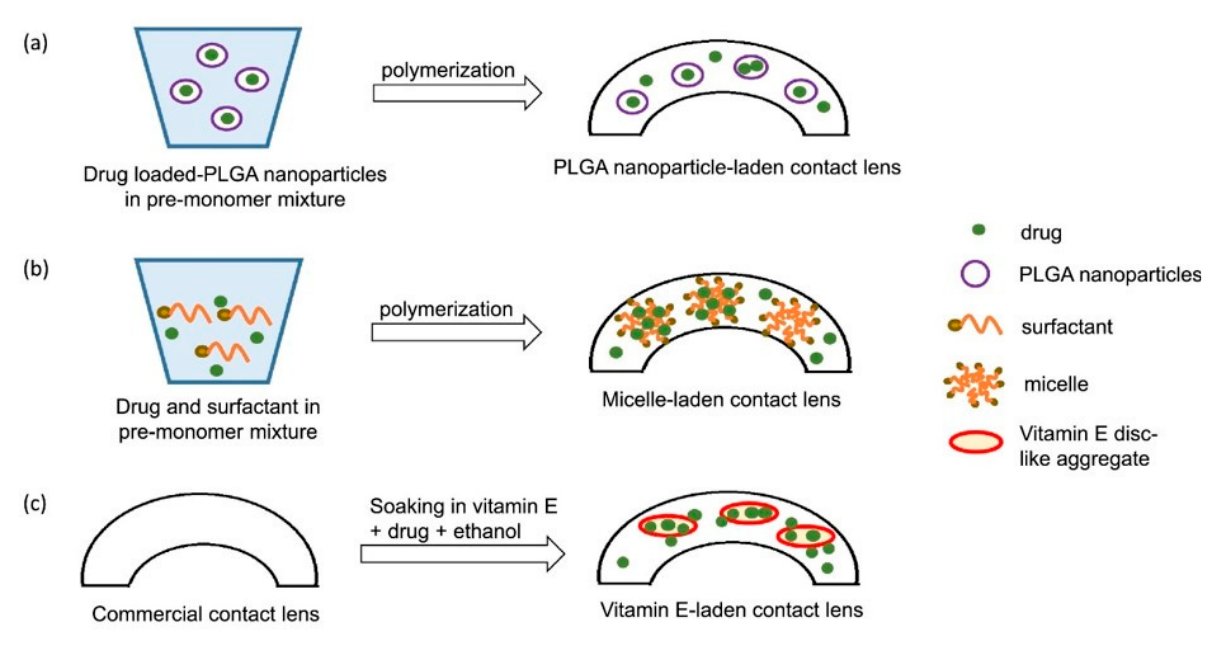
Figure 3. Hydrophobic drug controlled release techniques from soft contact lenses. ( a ) Nanoparticles loaded contact lenses. ( b ) Contact lenses with micelles. ( c ) Vitamin E fused contact lenses. Reprinted with permission from reference [72]. Copyright 2020 Elsevier. Table 3. DED treatment with contact lens drug delivery systems.